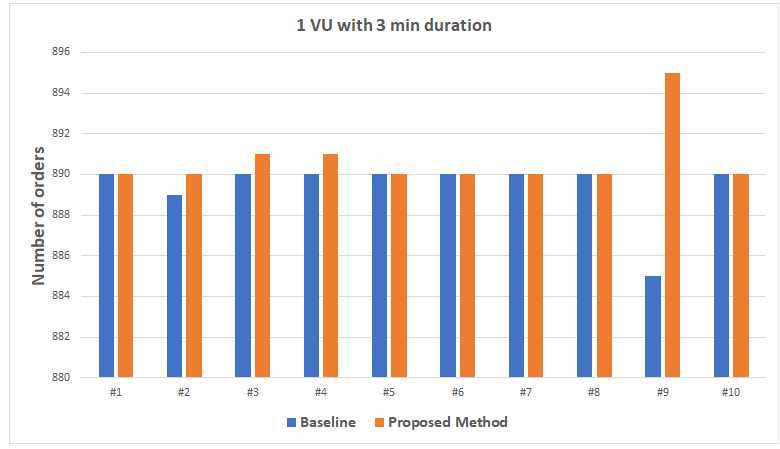
Figure 19. Load Testing—1 virtual user with 3 min duration.